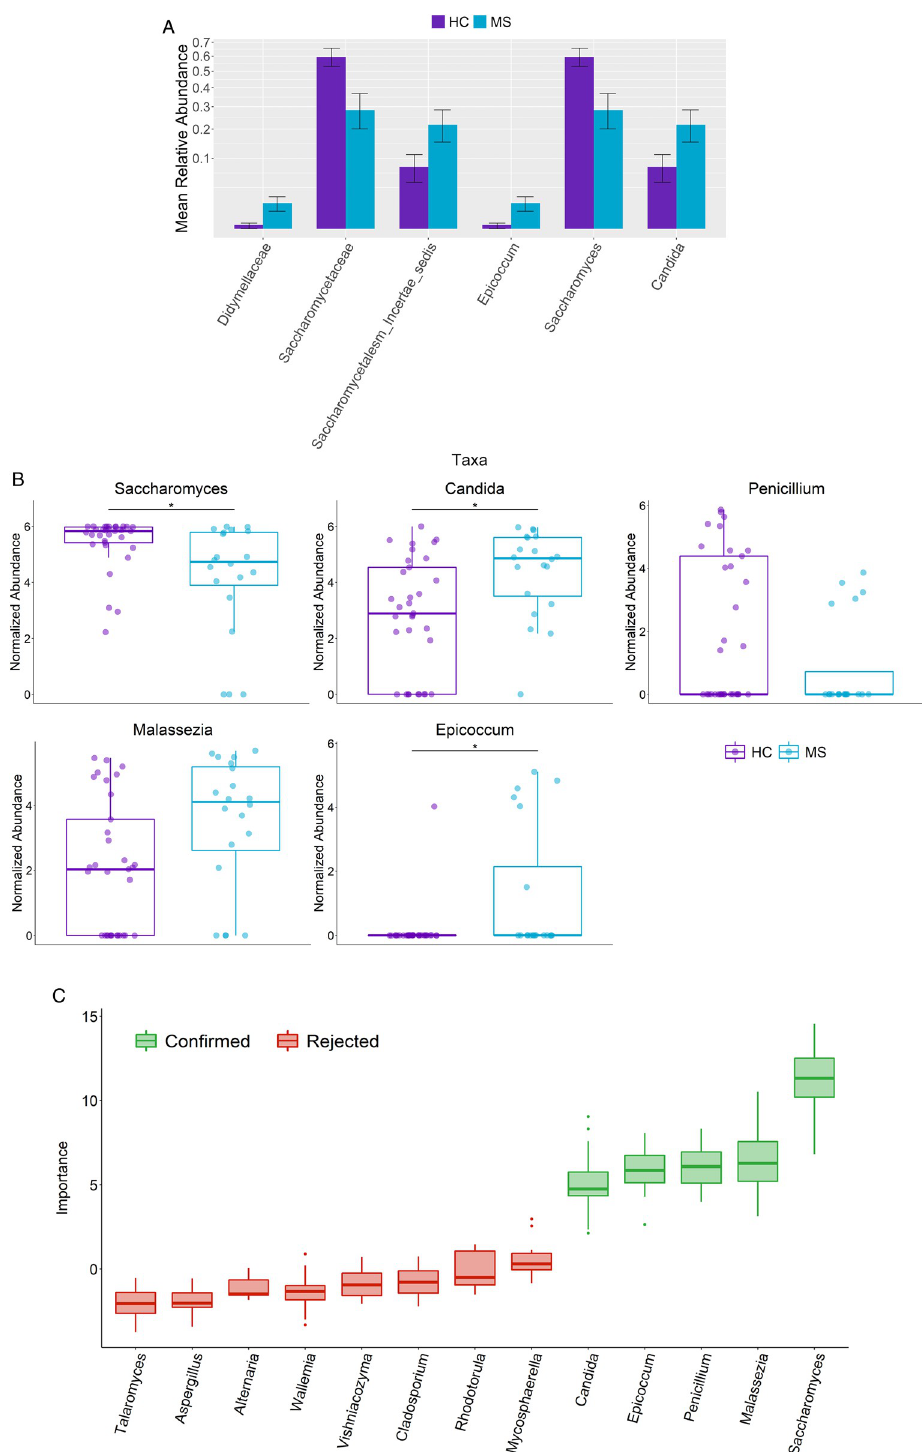
Fig 2. Differentially abundant fungal genera in RRMS versus healthy controls. (A) Bar plot showing relative abundances of differentially abundant taxa (p < 0.05) at the phylum, family, and genus level. (B) Differentially abundant fungal genera in MS and HC using Wilcoxon signed rank test and adjusted for multiple comparisons with the Benjamini-Hochberg method at a significance level of 0.05. Candida , Epicoccum , and Malassezia are increased in MS compared to HC. Saccharomyces is decreased in MS compared to HC. Penicillium was identified in random forest